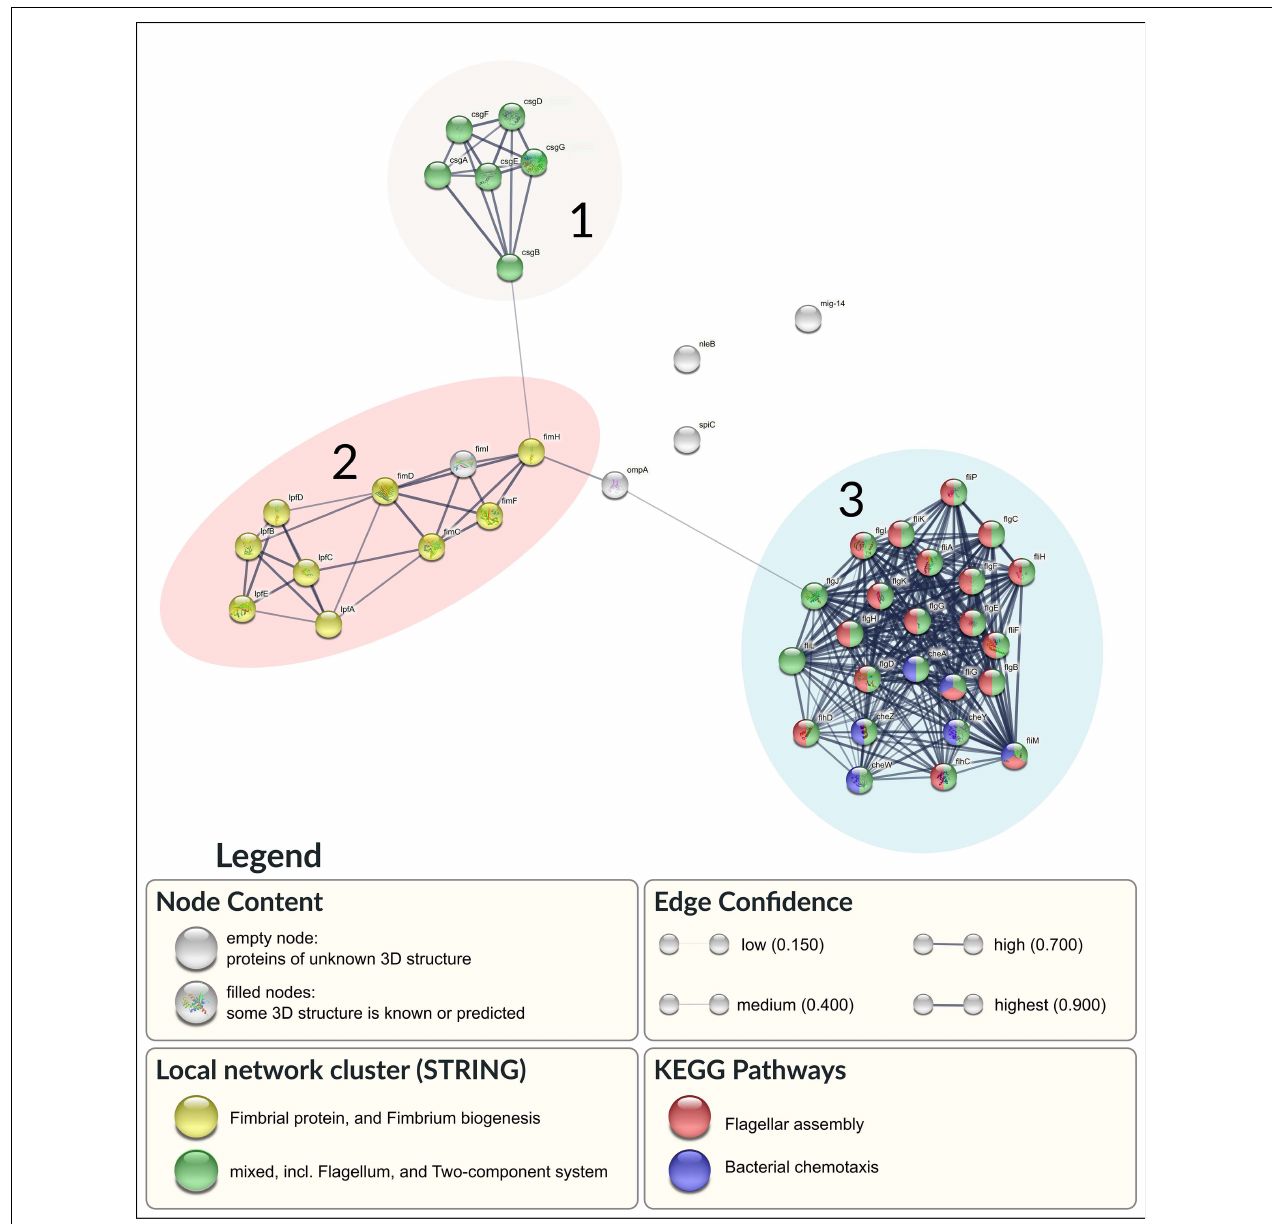
FIGURE 5 | Association network in STRING of the 44 selected proteins. Network nodes represent proteins. Proteins with enriched pathways are colored by red (Flagellar assembly) and blue (Bacterial chemotaxis). Additional node clustering is highlighted in yellow (Fimbria biogenesis) and green (Flagellum and Two-component system). Edges represent predicted protein-protein association with specific confidence score, according to its